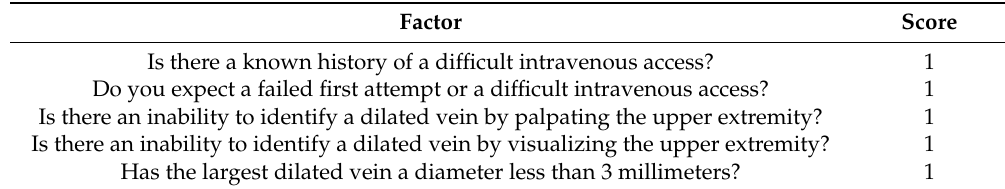
Table 4. The additive A-DIVA